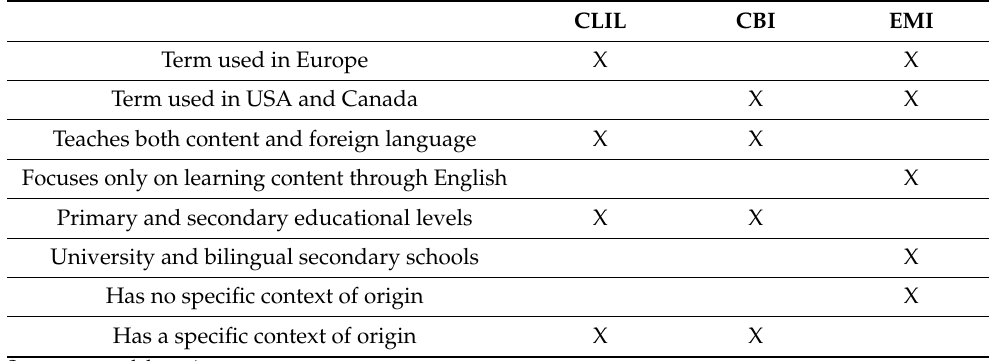
Table 1. Commonalities and differences between CLIL, CBI, and